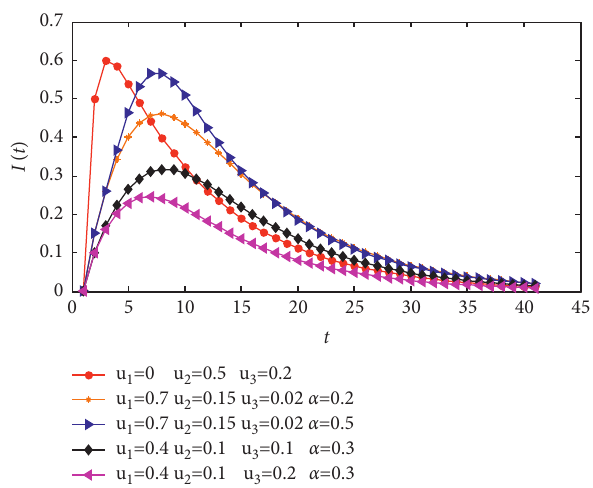
Figure 10: I ( t ) changing trend with t (the changes of I ( t ) density with t in five parameter networks are compared. This is helpful to investigate the factors affecting the change of I